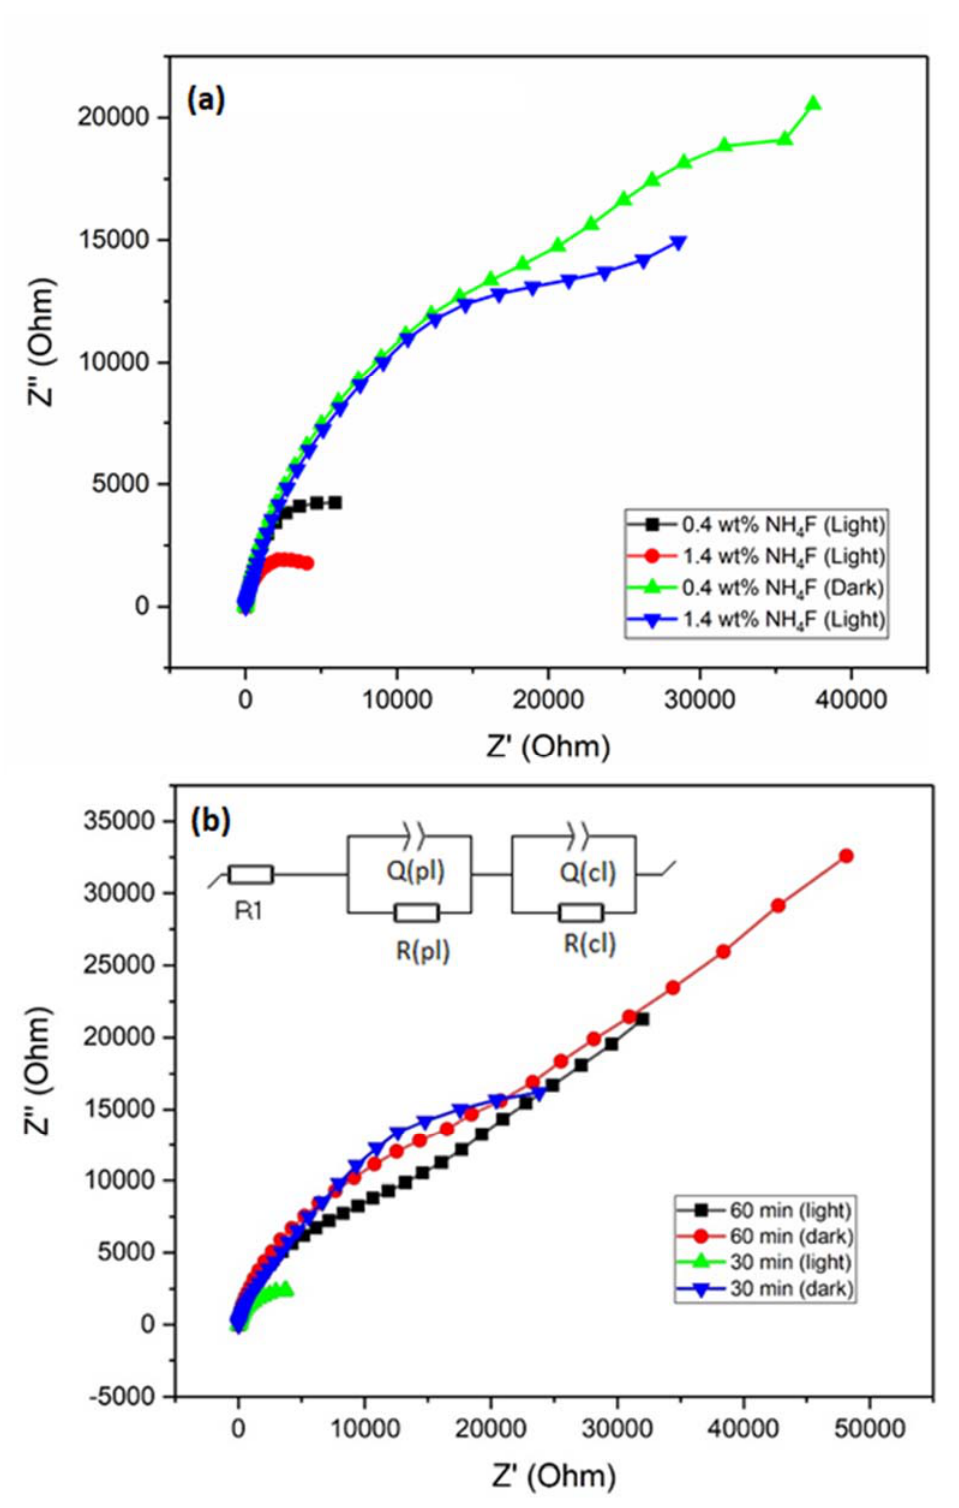
Figure 8. Nyquist plots for measured in the dark and under UV irradiation at 365 nm. ( a ) TiO 2 nanotubes prepared using different ammonium fluoride concentrations. ( b ) TiO 2 nanotubes prepared at different anodization times.